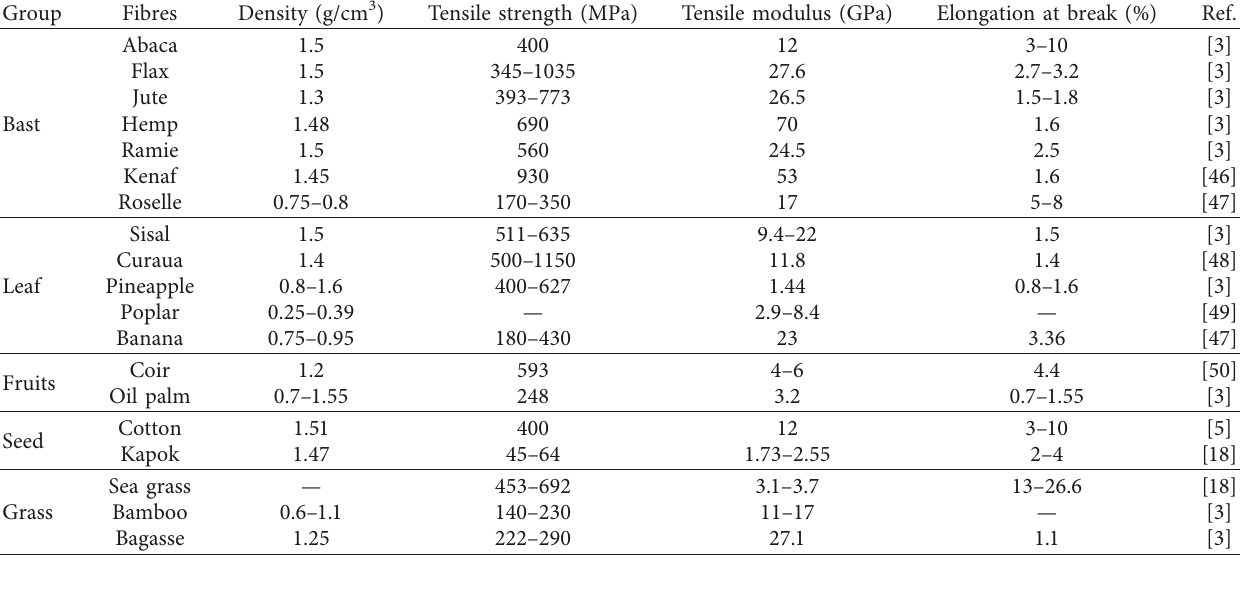
Table 2: Physical and mechanical properties of PF.